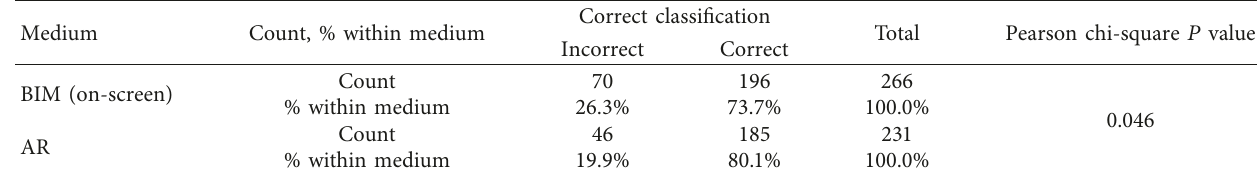
Table 7: Effect of visualization medium on maintainability